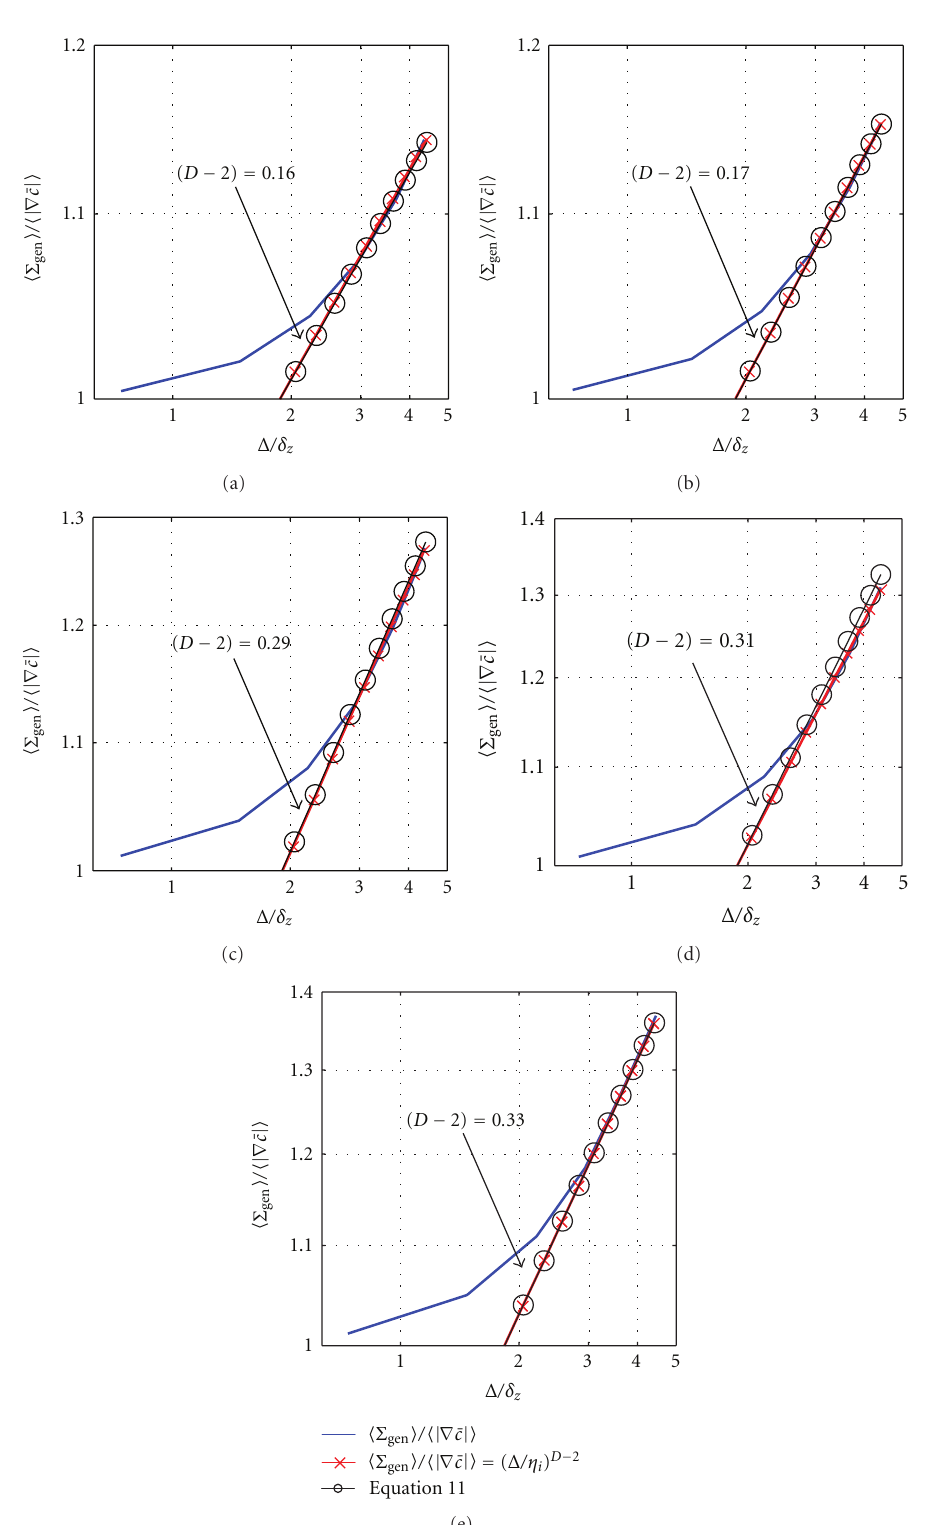
Figure 9: Variation of (cid:5) Σ gen (cid:6) / (cid:5)|∇ c |(cid:6) with Δ /δ z on a log-log plot for (a–e) cases A1–E1. The prediction of (cid:5) Σ gen (cid:6) / (cid:5)|∇ c |(cid:6) = ( Δ /η i ) D − 2 with η i obtained from DNS and ( D − 2) according to (11) is also